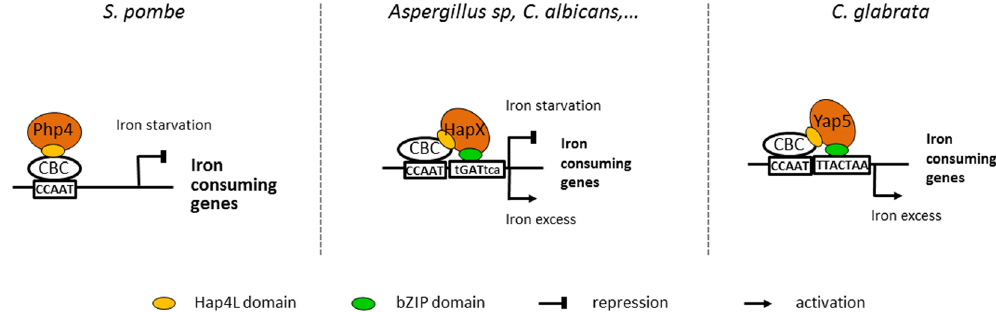
Figure 6. The evolution of the roles of CBC and its regulatory subunits in the control of fungal iron homeostasis. In Schizosaccharomyces pombe , Php4 plays an important role in the iron starvation response by repressing the iron consuming genes through its interaction with the CCAAT Binding Complex (CBC) which is mediated by its Hap4Like domain (Hap4L) (reviewed in ref. 15). In C. glabrata , Yap5 is a major regulator of the iron stress response which activates iron consuming genes 21, 29 . Yap5 binding to its targets requires CBC, probably by direct interaction with Hap5 through its vestigial Hap4L domain (this work). However, Yap5 also interacts directly with DNA through its bZIP domain and this interaction is essential for its regulatory activity 29, 35, 36 . Interestingly enough, the situation in filamentous ascomycetes (e.g. Aspergillus or Fusarium species) and in C. albicans is an intermediate between S. pombe and S. cerevisiae . HapX plays an important dual role in activating the iron stress response and in repressing the same genes in iron starvation 11, 12, 18, 20 . HapX interacts with CBC through its conserved Hap4L domain, but it also directly contributes to the binding of the CBC-HapX complex to a bipartite DNA motif, probably through its bZIP sequence 18, 20, 24, 25